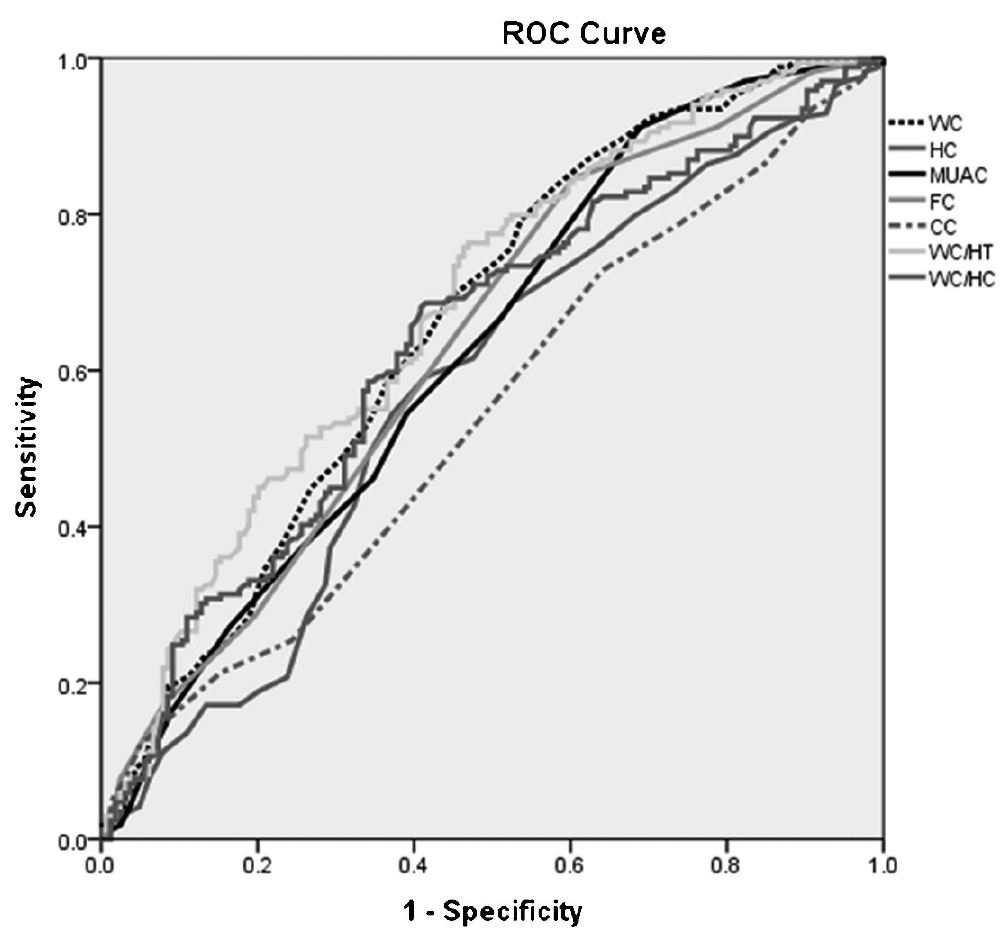
Figure 1 - Receiver-operating characteristic curves of anthropometric measurements. WC: waist circumference; HC: hip circumferance; MUAC: mid upper arm circumferance; FC: forearm circumferance; CC: calf circumferance; WC/ht: waist-to-height ratio; WC/HC: waist- to-hip